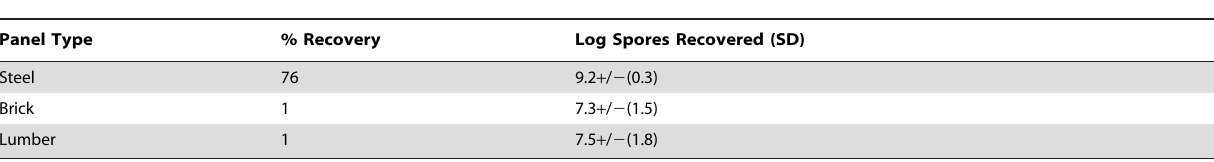
Table 1. Relative spore recovery from untreated